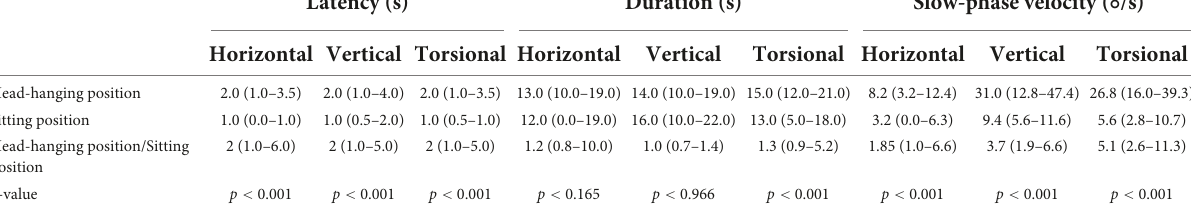
TABLE 4 Comparison between the head-hanging position and sitting position nystagmus of 84 patients with PSC-can. Latency